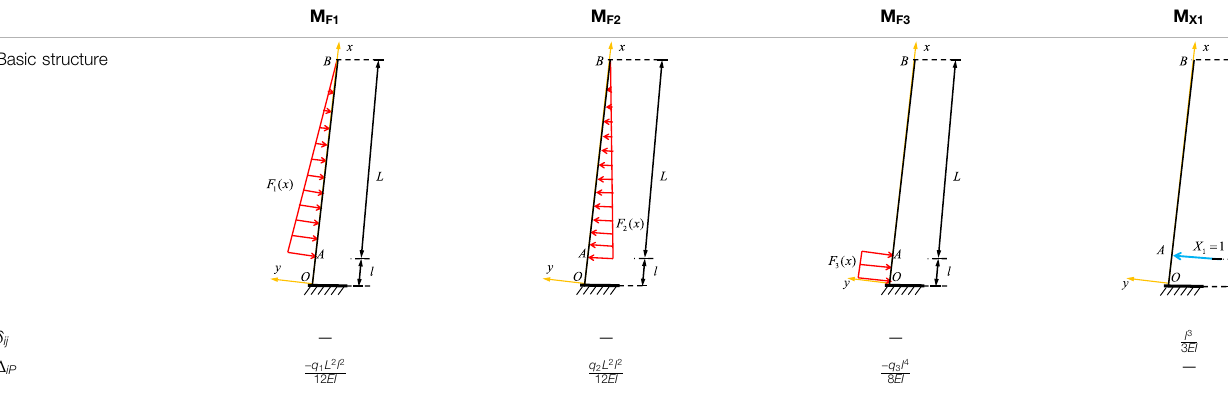
TABLE 1 | Bending moment diagram of the rock pillar ’ s basic structure under different loads. M F1 M F2 M F3 M X1